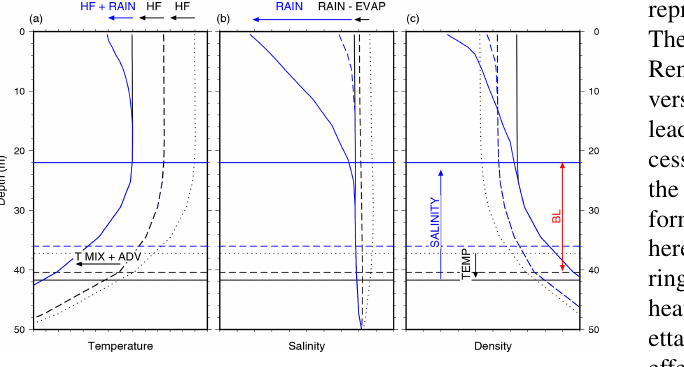
Figure 15. Diagram of the upper-layer evolution in temperature (a) , salinity (b) , and density (c) in the REF (black) and HR (blue, when it differs from REF) zones. The profiles of parameters are indicated at the beginning (dotted), middle (dashed), and end (solid) of the event. The horizontal lines indicate the MLD in the REF (black) and HR (blue) zones at the beginning (dotted), middle (dashed), and end (solid) of the simulation. The horizontal arrows indicate the processes at the origin of the profile changes: surface heat fluxes (HF), rain forcing (RAIN), evaporation (EVAP), turbulent mixing ( T MIX), and horizontal advection (ADV) in black for the REF zone and blue for the HR zone. The vertical arrows in (c) indicate the parameters controlling the changes in MLD in the REF (black) and HR (blue) zones. The red arrow indicates the BL in the HR